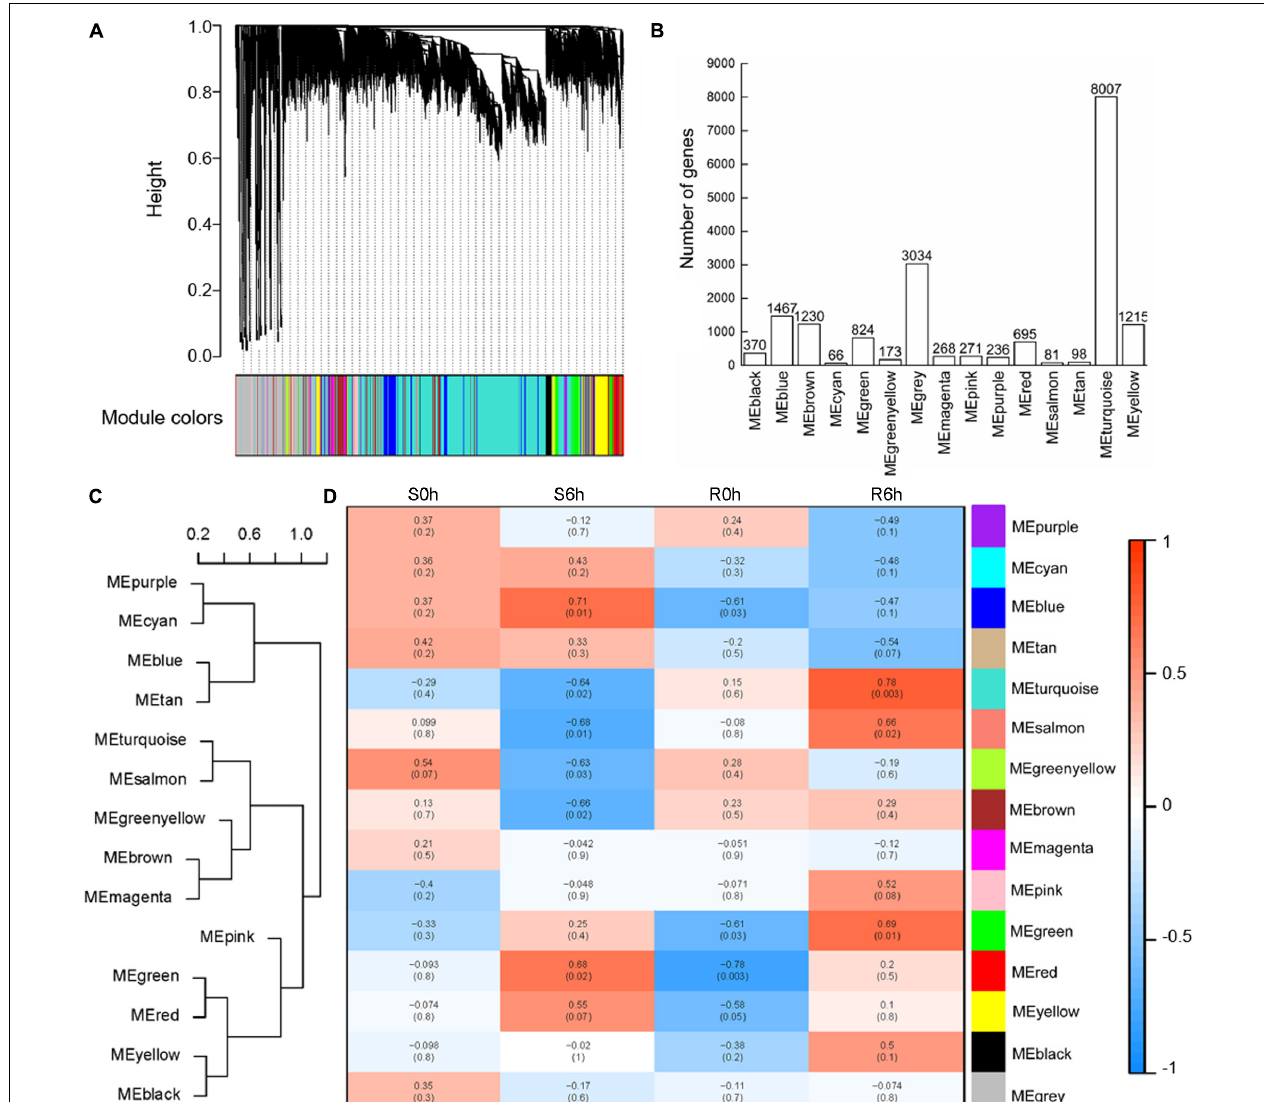
FIGURE 6 | WGCNA analysis of key modules related to P. xanthii defense in cucumber. (A) Clustering dendrogram of co-expression modules. (B) The number of genes detected in each module. (C) Heat maps of gene expression in each module. Cluster tree (C) and heat maps (D) of gene expression in each module.